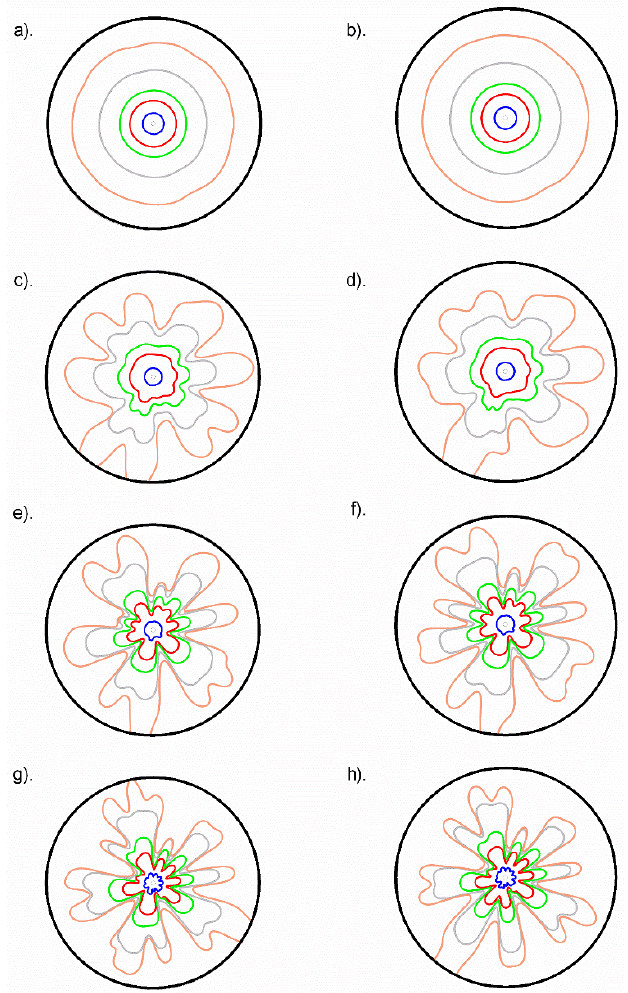
Figure 3. Temporal evolution of fingering for Darcy’s model (left column) and modified Darcy model (right column) for Re = 2.2 × 10 − 5 and Pe = 1.45 × 10 − 2 at different times: t = 150 s (blue), t = 750 s (red), t = 1550 s (green), t = 4000 s (grey), and t = 9000 s (orange). Values are changed with rows as R = 2 for ( a , b ), R = 4 for ( c , d ), R = 6 for ( e , f ) and R = 8 for ( g , h